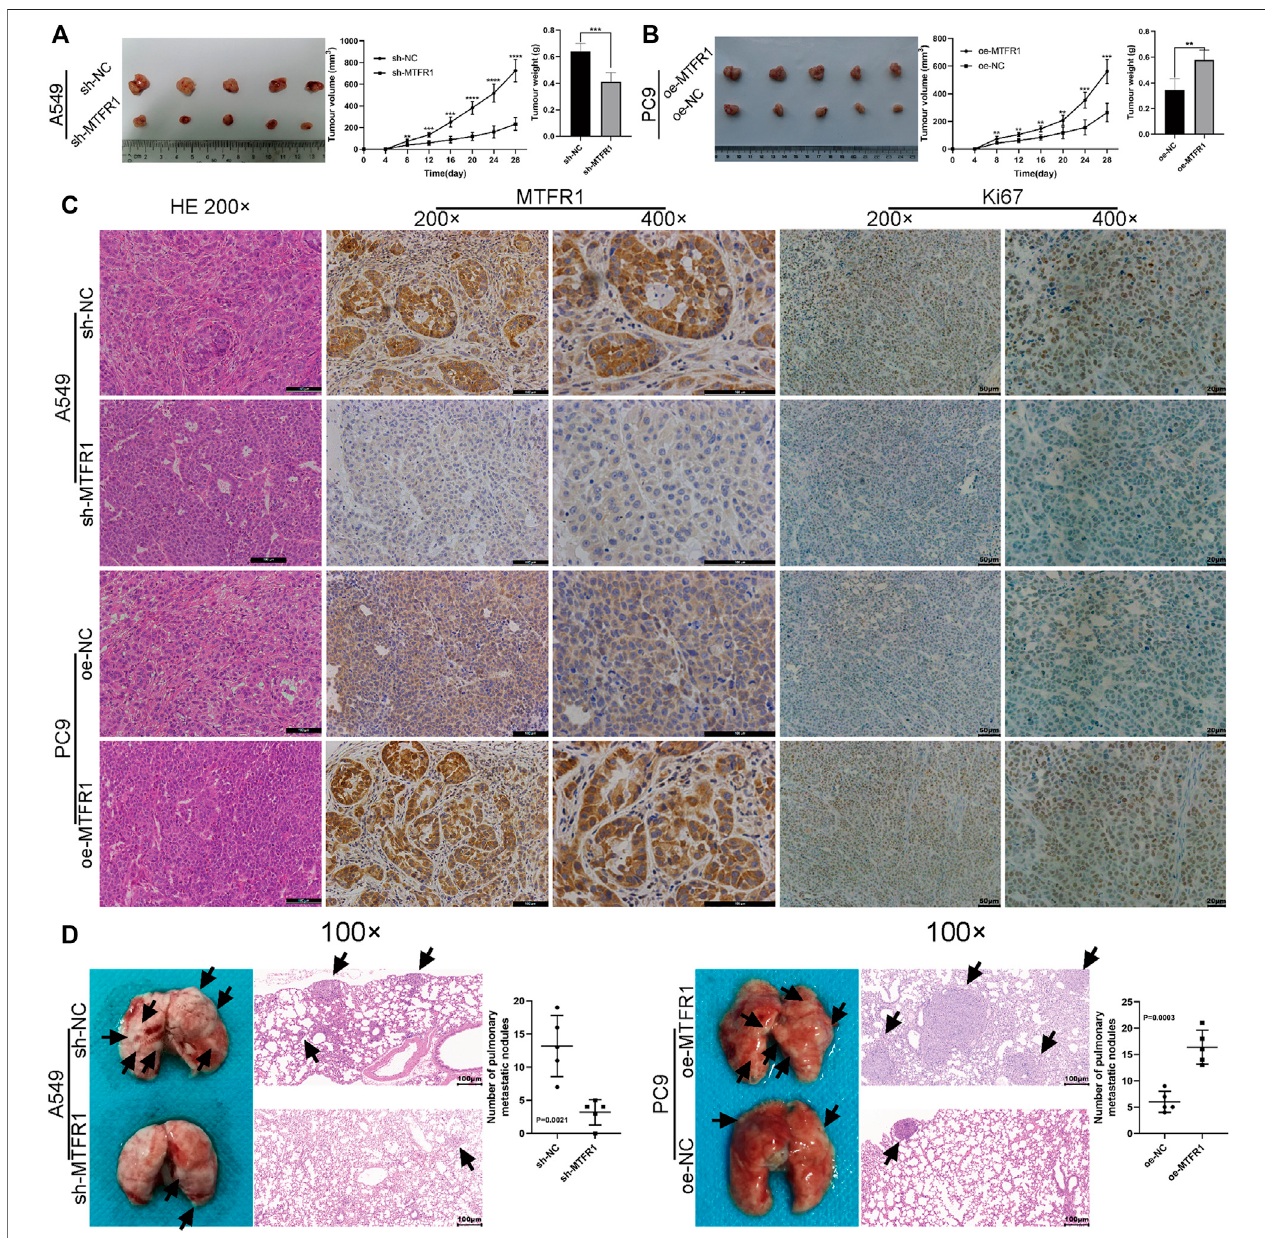
FIGURE 9 | MTFR1 promoted the progression of LUAD cells in vivo . (A,B) Tumour images, tumour growth curves and tumour weights of each group. (C) Haematoxylin – eosin (HE) staining and immunohistochemical analysis of the Ki-67 and MTFR1 proteins of tumours in each group. (D) Photographs (left) and HE-stained images (right) of the lungs in each group; the black arrowheads denote lung metastasis nodules (** p < 0.01, *** p < 0.001, **** p < 0.0001).